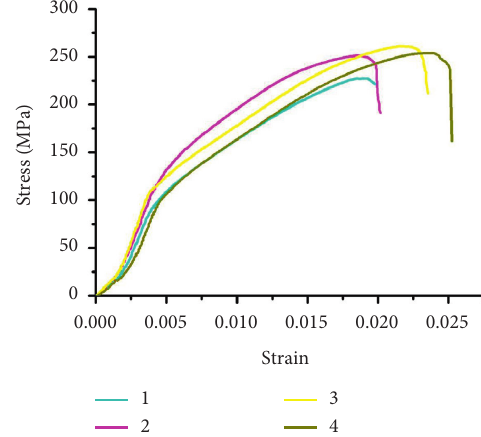
Figure 7: Stress-strain curve of the developed composites. (1) Mg alloy; (2) coated Al 2 O 3 ; (3) coated SiC; (4) coated Al 2 O 3 +SiC.